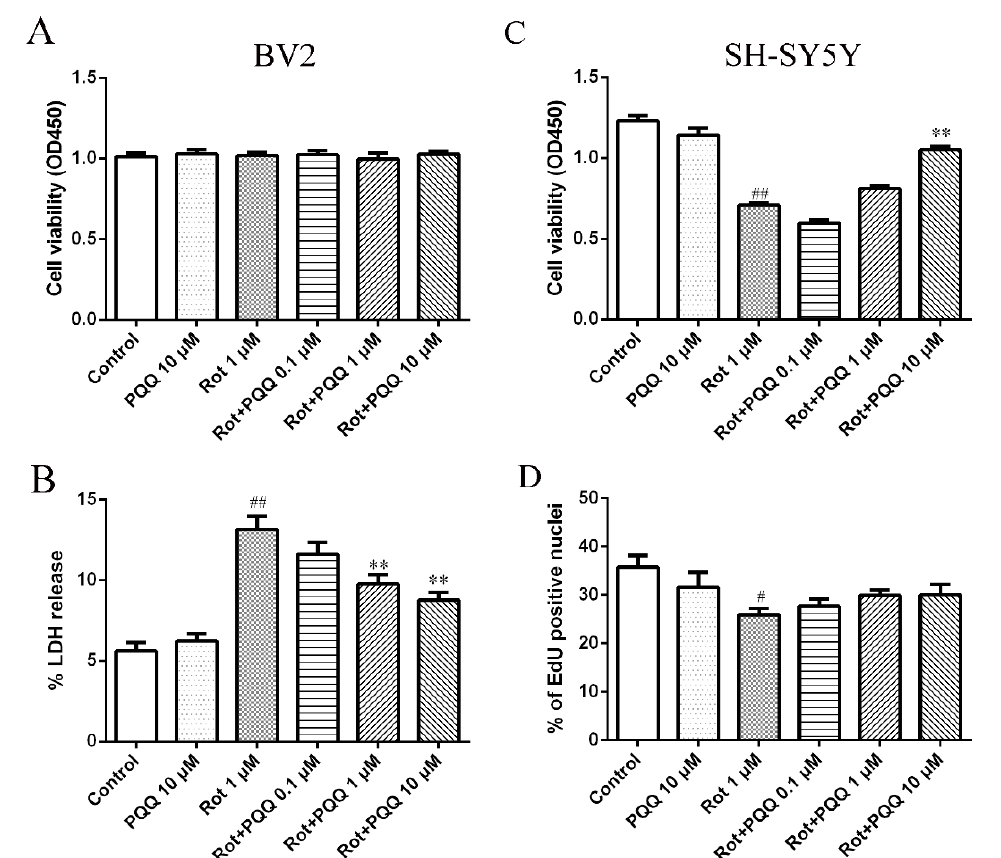
Figure 1. Pyrroloquinoline quinone (PQQ) rescued rotenone-induced microglia-mediated cell death. BV2 microglia cells were pre-treated with different doses (0.1, 1, 10 μM) of PQQ for 2 h before rotenone (1 μM) incubation for another 12 h. ( A ) Cell viability was measured with CCK-8 assay. No significant changes were observed in any group. ( B ) Lactate dehydrogenase (LDH) release in BV2 cells was measured. ( C ) The conditioned medium (CM) was collected from BV2 cells that were pre-treated with different doses (0.1, 1, 10 μM) of PQQ and rotenone for 12 h. SH-SY5Y cells were incubated with the CM from BV2 cells for 24 h and cell viability was measured with CCK-8 assay. ( D ) Cell proliferation of SH-SY5Y cells was measured with 5-ethynyl-2′-deoxyuridine (EdU) incorporation. The data were presented as the mean ± SEM from three or four independent experiments. For CCK-8 assay, 10 wells were included in one experiment. ** p < 0.01 vs. rot group (only treated with rotenone); # p < 0.05, ## p < 0.01 vs. control group (no rotenone or PQQ treatment).